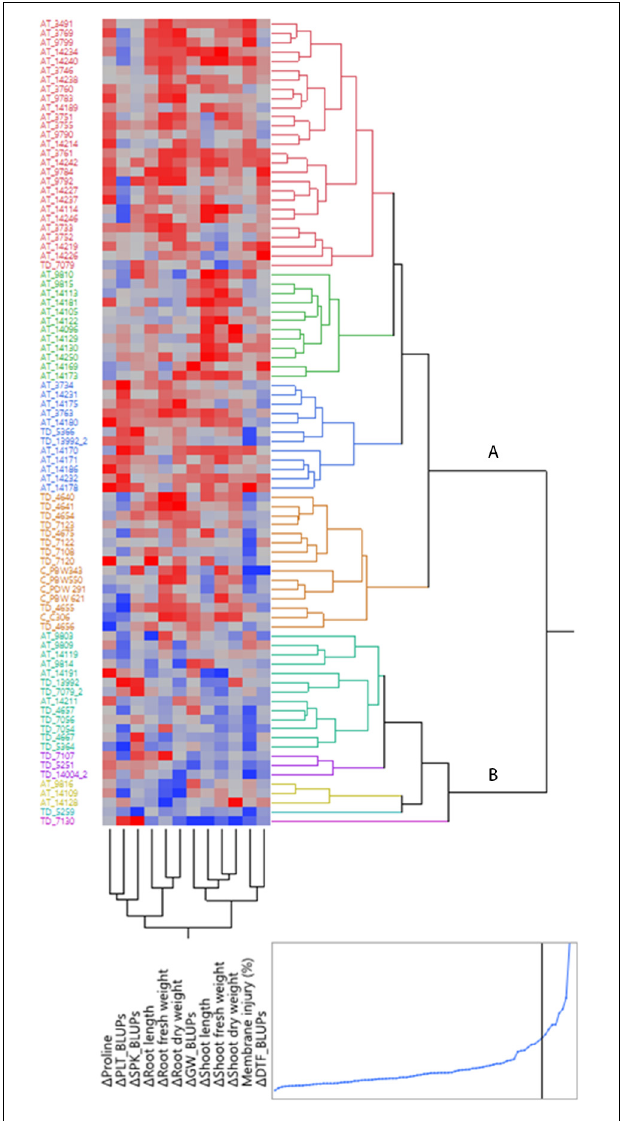
FIGURE 9 | Hierarchical cluster analysis (HCA) of early stage adaptive plasticity traits and BLUP derived tolerance indices in wheat germplasm set. AT, TD, and C correspond to accessions of Aegilops tauschii , Triticum dicoccoides and check wheat cultivars, respectively. Each accession is visualized in a single row and each trait value is represented by a single column. Red indicates unfavorable change or reduction in trait value, whereas less of the unfavorable change or increase in trait value is depicted in